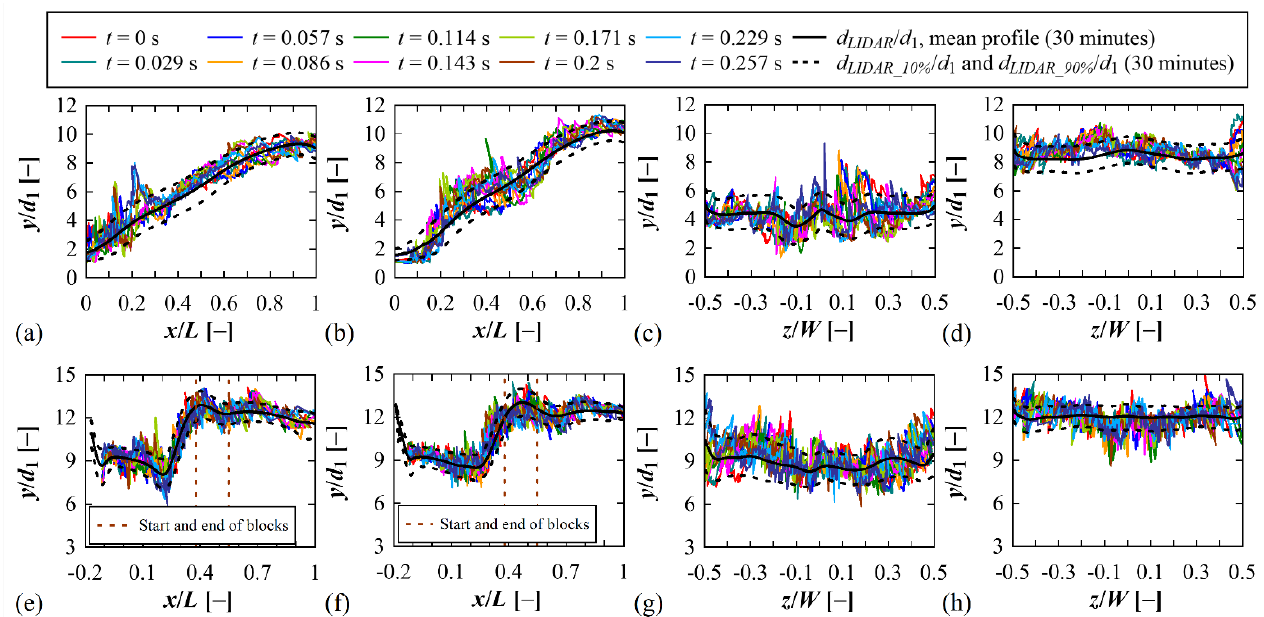
Figure 3. Longitudinal and transverse instantaneous free-surface profiles for 10 consecutive frames with a time interval of 0.0286 s: ( a – d ) no blocks with ( a ) longitudinal, Fr 1 = 8.7, z / W = − 0.36; ( b ) longitudinal, Fr 1 = 8.7, z / W = 0.11; ( c ), transverse, Fr 1 = 8.7, x / L = 0.26; ( d ) transverse, Fr 1 = 8.7, x / L = 0.72; ( e , f ) blocks with ( e ) longitudinal, Fr 1 = 9.4, z / W = − 0.36; ( f ) longitudinal, Fr 1 = 9.4, z / W = 0.11; ( g ) transverse, Fr 1 = 9.4, x / L = 0.26; ( h ) transverse, Fr 1 = 9.4, x / L = 0.72.